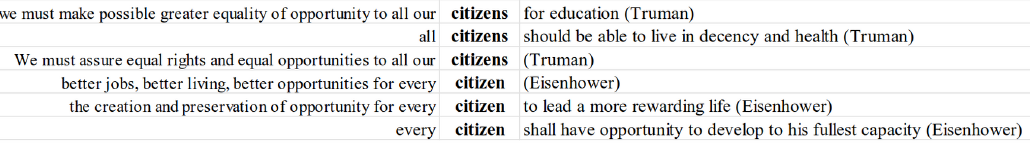
Figure 8: selected concordance lines of